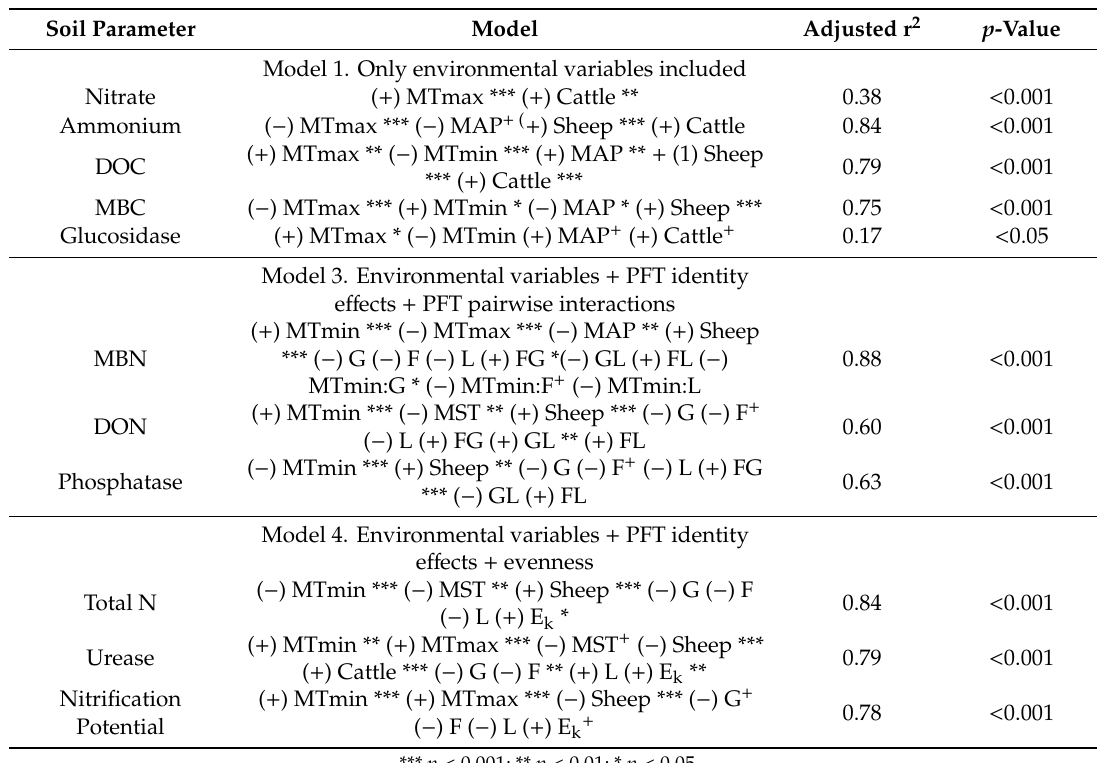
Table 3. Best fitted Generalized diversity-interaction models for soil activity and fertility parameters (response variables). The explanatory variables include climatic variables: MTmax = mean annual maximum air temperature; MAP = mean annual precipitation; MTmin = mean annual minimum air temperature; MST = mean summer air temperature; management variables: Cattle and sheep grazers; and plant functional type diversity variables: G = Grass, L = Legume, F = Forb; FG = forb-grass, GL = grass-legume and FL = forb-legume pairwise interactions; Ek = evenness. For more information on the coe ffi cients of the explanatory variables, see Table S1 in Supplementary